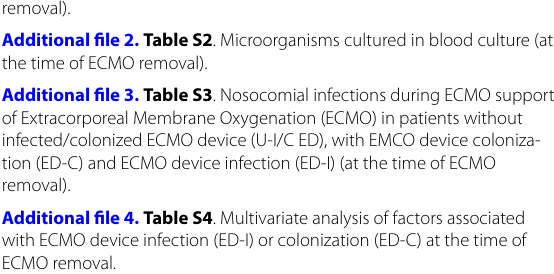
Data are provided as no. (%) of ECMO or median value (interquartile range) ECMO extracorporeal membrane oxygenation, ECMOFD ECMO-free day, ICU intensive care unit, LOS length of stay, MV mechanical ventilation, VFD ventilator- free day, U-I/C ED uninfected/uncolonised ECMO device, ED-C ECMO device colonisation, ED-I ECMO device infection a Among the 99 patients, 4 underwent 2 ECMO during their ICU stay corresponding to 103 VV-ECMO